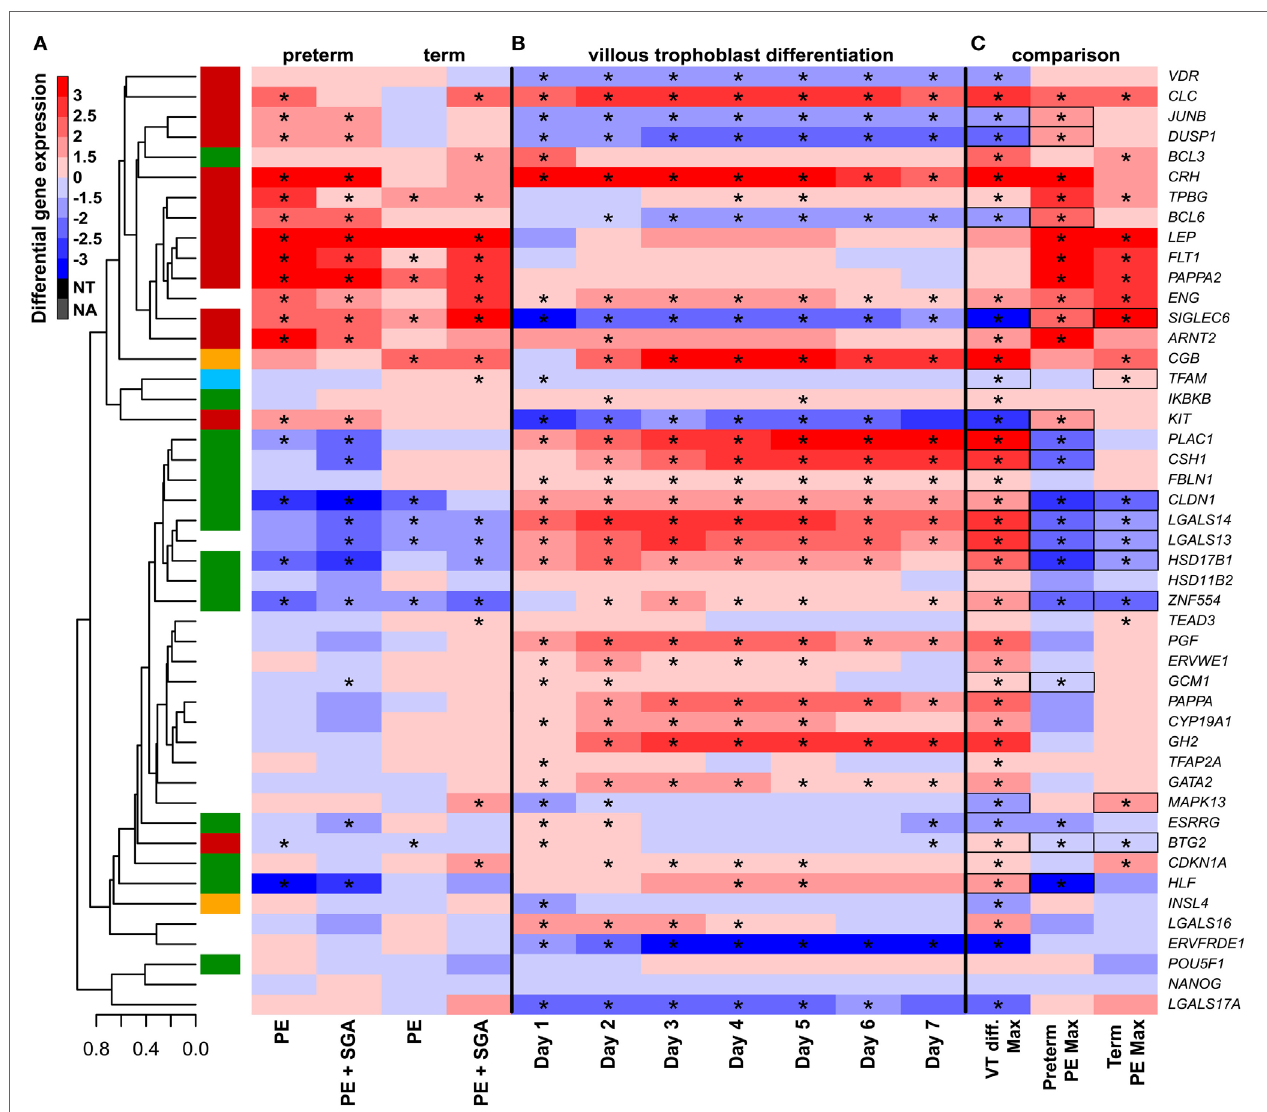
FigUre 7 | The effect of trophoblast differentiation on differentially expressed genes in preeclampsia. (a) Hierarchical clustering tree of expression data for 47 genes in 100 placental specimens was augmented with a heatmap representing differential gene expression in term or preterm subgroups of preeclampsia. (B) Primary villous trophoblast (VT) differentiation time series expression data for 47 genes were depicted with a heatmap representing differential gene expression in each time point (days 1–7) compared to day 0. (c) Maximum expression values in the VT differentiation time series were presented alongside with maximum expression values in the placenta in preterm or term preeclampsia. Comparative visualization revealed the opposite-direction differential regulation of 17 genes in preeclampsia compared to VT differentiation as depicted with black boxes. Among these genes, 15 had this behavior in preterm preeclampsia and 9 in term preeclampsia ( p = 0.057). In (a–c) , stars depict significant changes, color bar encodes signed (up or down)-fold changes. Abbreviations: NA, not expressed; NT, not